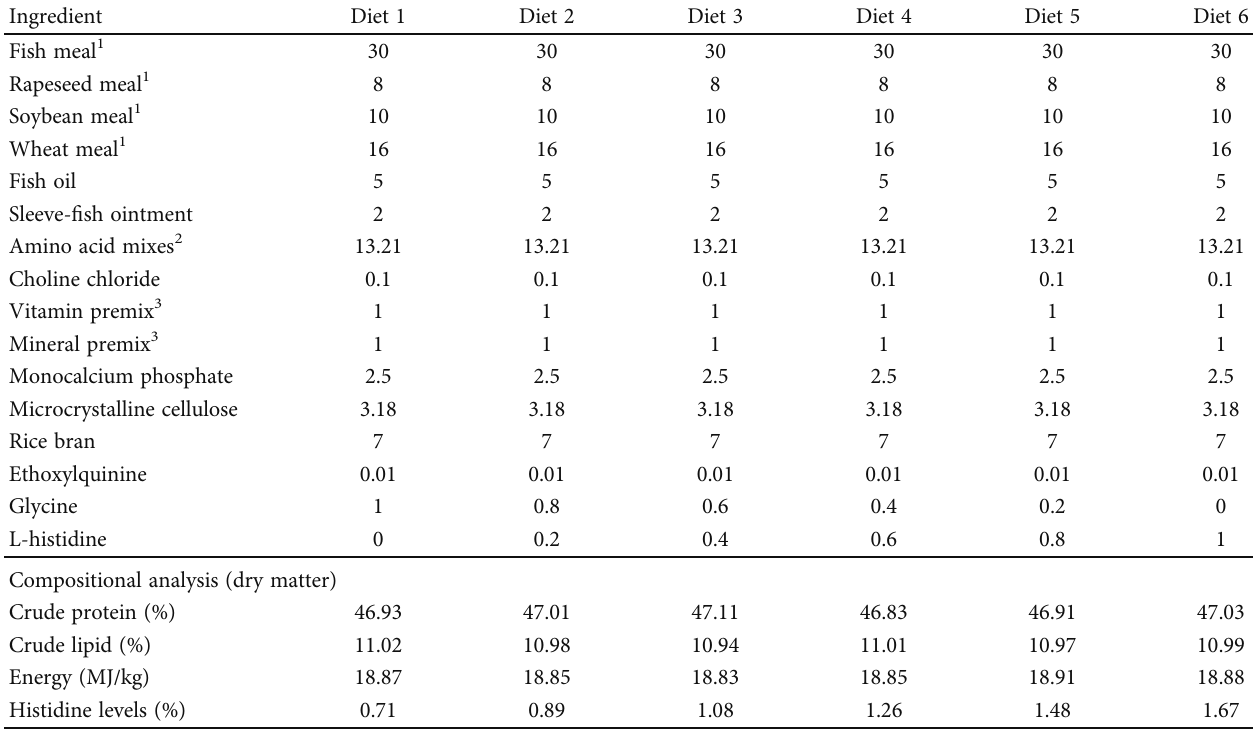
Table 1: Formulation and proximate composition of the experimental diets (%, dry